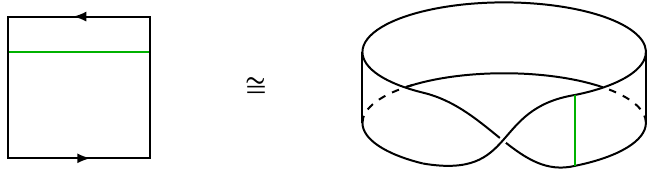
Figure 1: Möbius strip with an orientation-reversing line (in